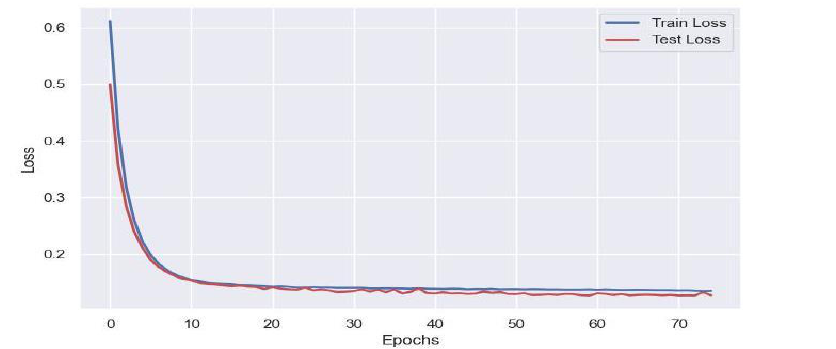
Figure 14. Loss of the neural